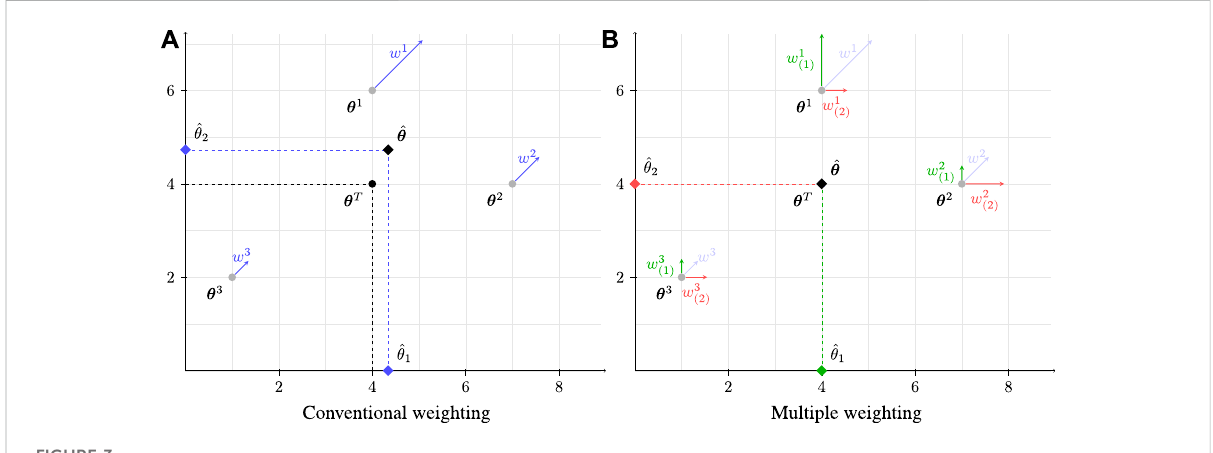
FIGURE 3 Comparison of a state-estimation using conventional (A) and the proposed MW (B) approaches applied to a simplistic two-dimensional scenariosolvedbymeansofaSIRPFwith N =3particles.Weights w i ,shownin (A) ,aresplitinindependentweights w i 1 , 2 andnormalizedforeachsub- state in (B)